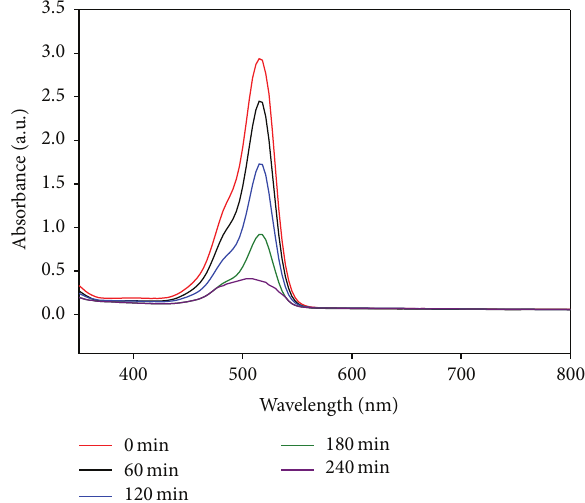
Figure 8: UV-Vis absorption spectra of eosin Y during the course of reaction with the synthesised Ag-MNP powder at different time intervals under ultraviolet light irradiation at room temperature.